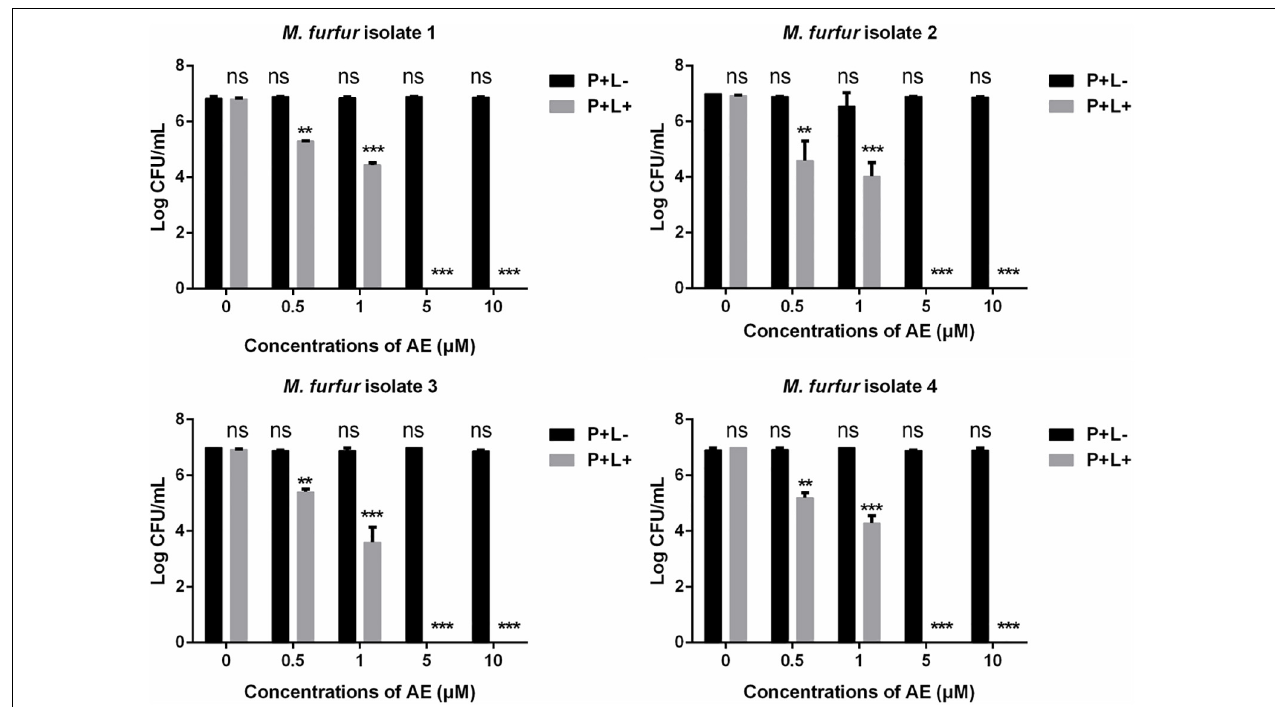
FIGURE 4 | Survival of M. furfur clinical isolates after aPDT mediated by AE. (P+L–) represents the M. furfur cells treated with different concentrations of AE in the dark; (P+L+) represents the M. furfur cells treated with different concentrations of AE and irradiated with 96 J cm − 2 of light. Each value refers to mean ± standard deviation (SD; n = 3; ns: no significance, ** P < 0.01, *** P <